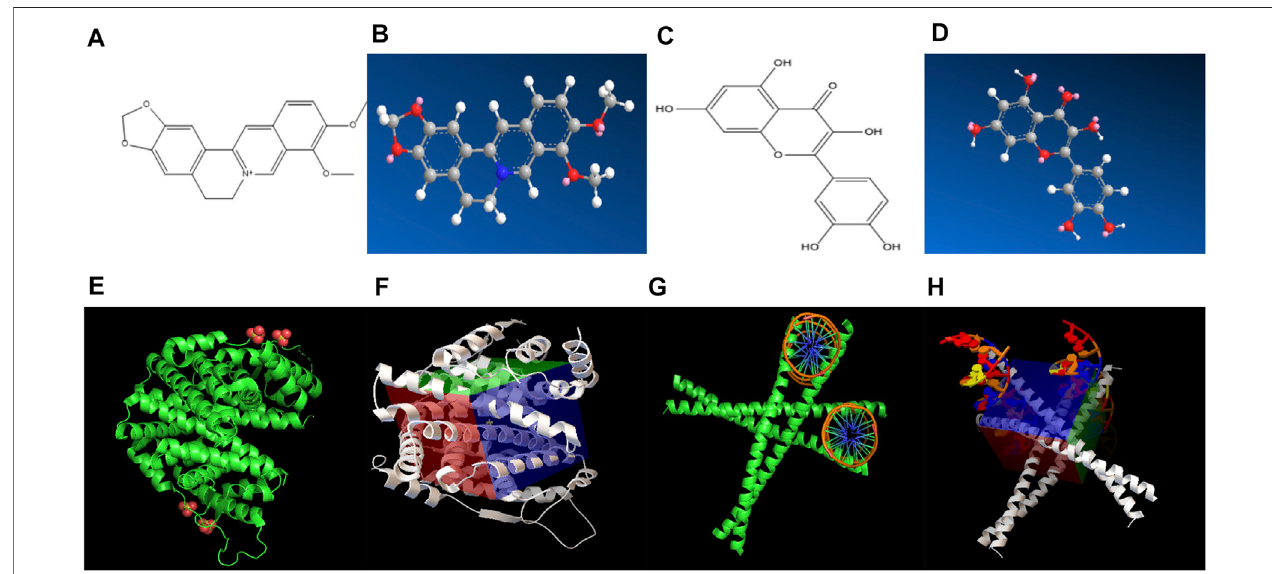
FIGURE 4 | (A) 2D chemical structure formula of ESR1 target molecule. (B) 3D chemical structure formula of ESR1 target molecule. (C) 2D chemical structure formula of FOS target molecule. (D) 3D chemical structure formula of FOS target molecule. (E) ESR1 target molecule and compound molecular docking diagram of Scutellariabaicalensis . (F) ActivepocketfordockingESR1targetandcompoundmoleculesof Scutellariabaicalensis . (G) DockingdiagramofFOStargetandcompound molecules of Scutellaria baicalensis . (H) Active pocket for docking FOS target and compound molecules of Scutellaria baicalensis .